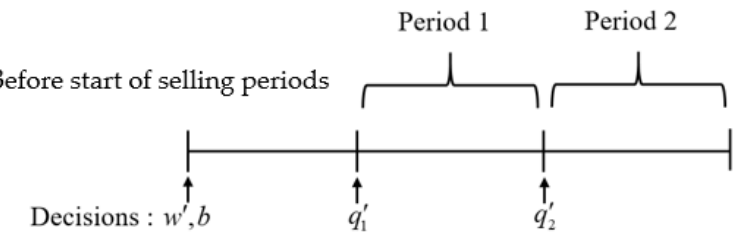
Figure 2. Timeline of decision making in Model